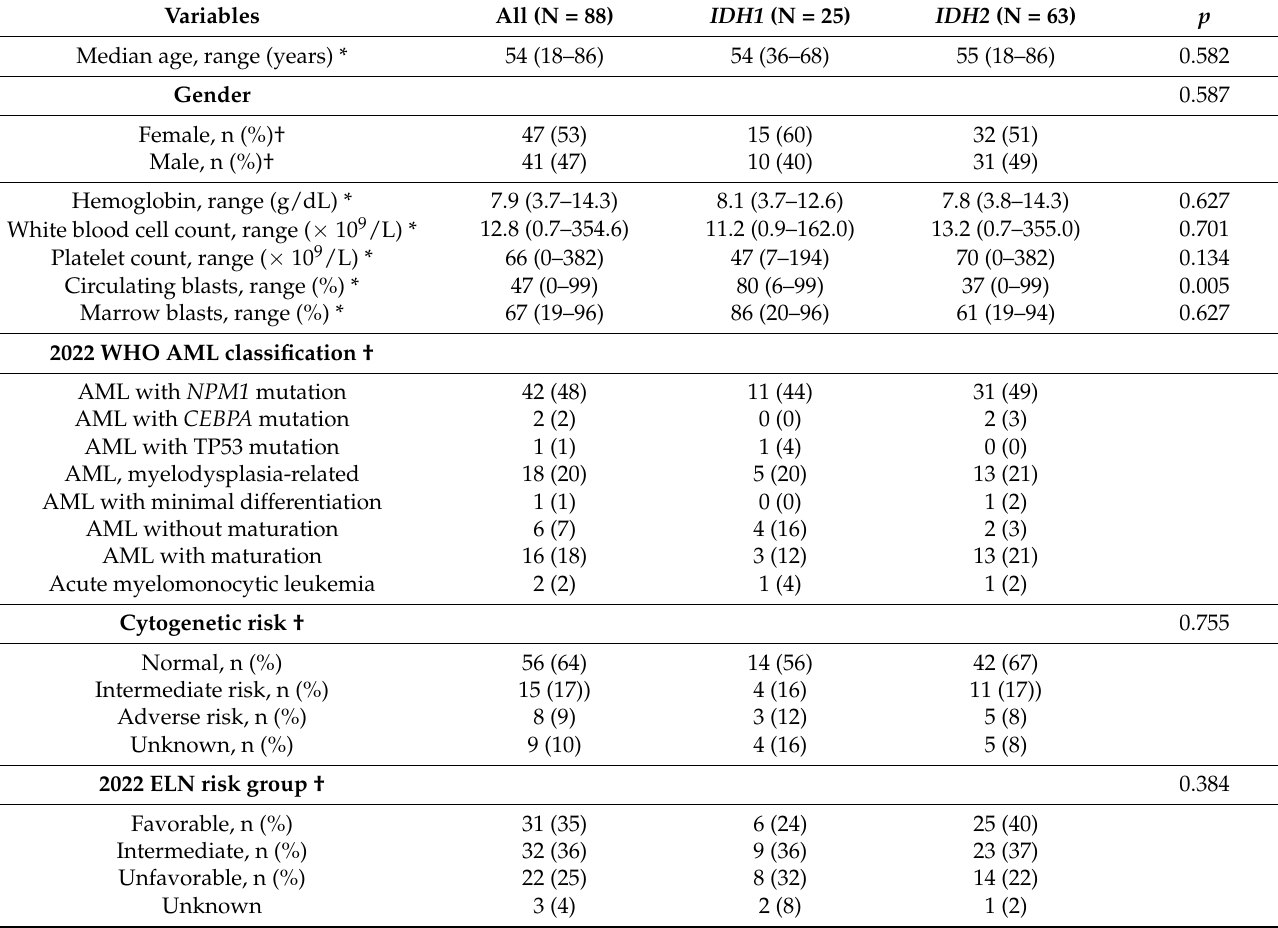
Table 2. Clinical and genetic characteristics of IDH1/2- mutated AML